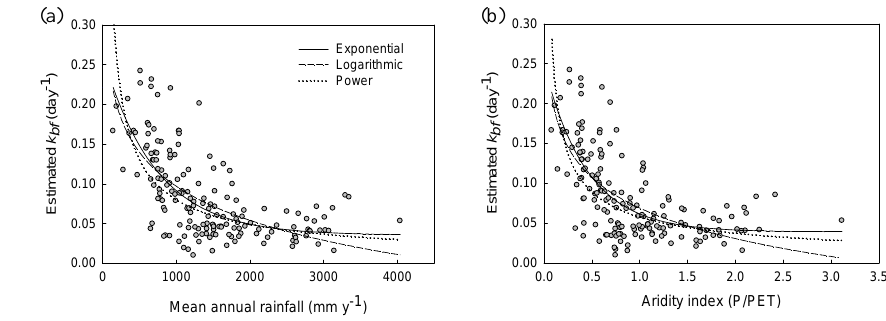
Fig. 6. Regression equations for (a) MAR versus k bf and (b) AI versus k bf Figure 6. Regression equations for (a) MAR versus k bf and (b) AI versus k bf 1